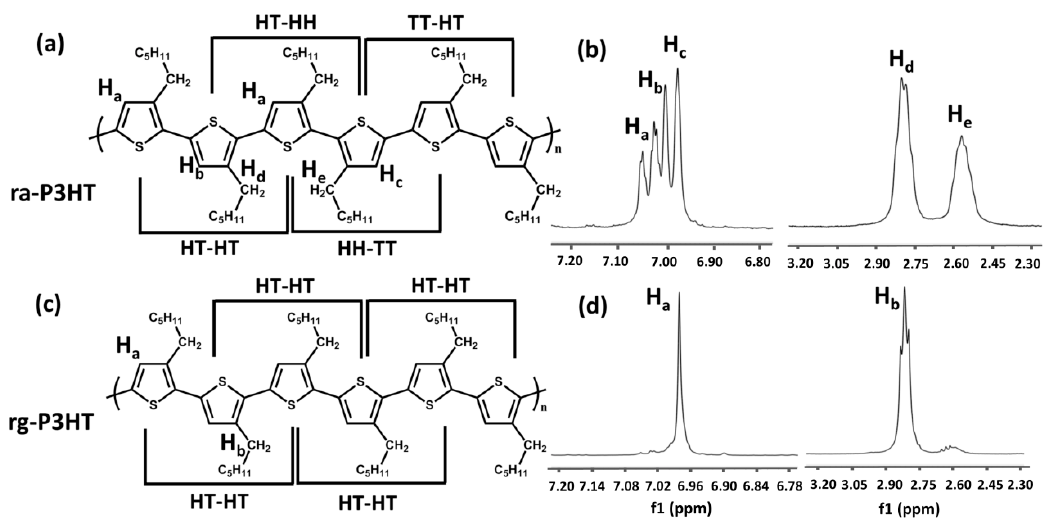
Figure 1. ( a ) Molecular structure of random poly(3-hexylthiophene) (ra-P3HT) with HT-HT:HT-HH:TT-HT:HH-TT=1:1:1:1; ( b ) 1H-NMR spectra of random P3HT with characteristic peaks of protons in thiophene rings in chemical shifts near δ = 7.0 ppm, and characteristic peaks of protons in α -methylene protons of hexyl group in chemical shifts near δ = 2.4–2.8 ppm; ( c ) Molecular structure of regular P3HT (rg-P3HT) with HT-HT-only structure; ( d ) 1H-NMR spectra of regular P3HT with characteristic peaks of protons in thiophene rings in chemical shifts near δ = 7.0 ppm, and characteristic peaks of protons in α -methylene protons of hexyl group in chemical shifts near δ = 2.4–2.8 ppm.